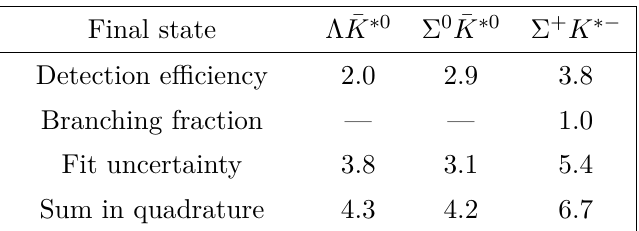
Table 7 . Relative systematic uncertainties (%) in the branching fraction measurements. The uncertainty of 28.9% on B (Ξ 0 → Ξ − π + ) [3] is treated as an independent systematic uncertainty. c celed by the reference mode of Ξ 0 → Ξ − π + . The detection efficiency uncertainties include c those from tracking efficiency (0.35%/track), particle identification efficiency (1.1%/kaon, 0.9%/pion, and 2.9%/proton), K 0 selection efficiency (2.23%), π 0 reconstruction S